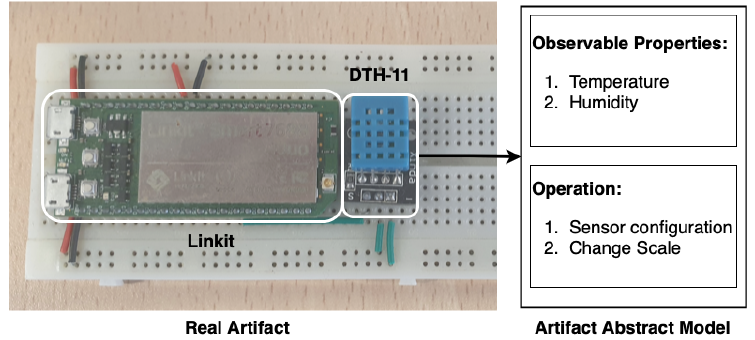
Figure 9. IoT Artifact for temperature and humidity